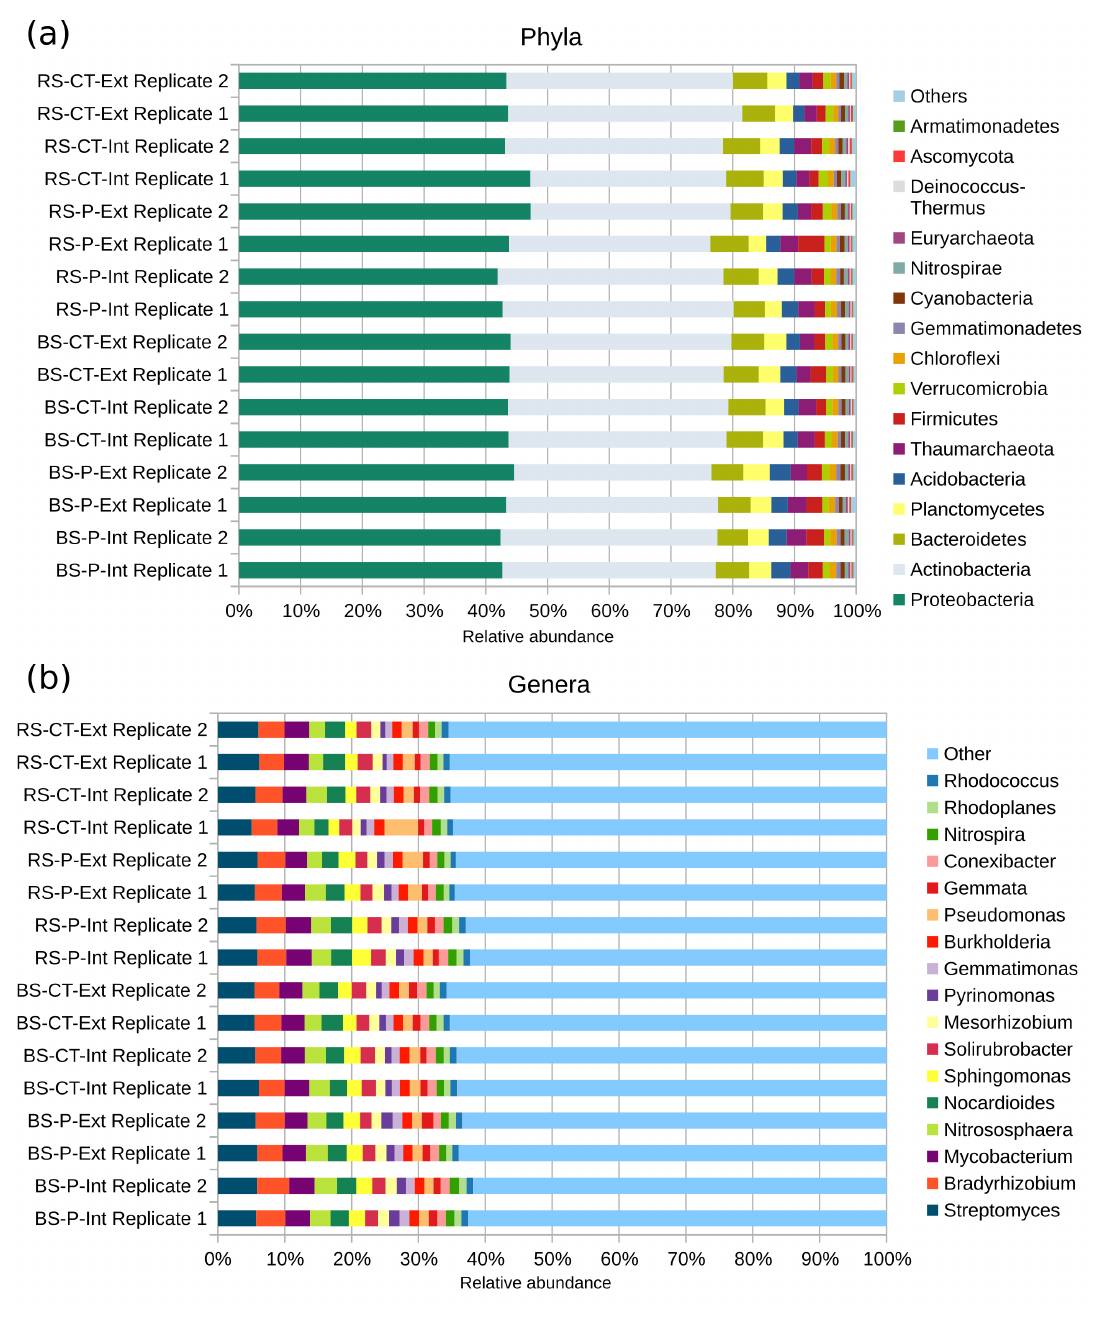
Figure 2. Taxonomic profiling of the soil microbial communities residing in the analyzed LTE-1 field plots on the rank of ( a ) phyla and ( b ) genera. Relative abundances of the most abundant phyla/genera are shown and were determined based on direct classification of reads normalized to the dataset sizes (fractions). In addition, 54 phyla and 3075 genera with relative abundances of less than one per mill or one percent, respectively are compiled as ‘Others’. The colors are ordered right-to-left according to the legend top–down. Abbreviations stand for bulk soil (BS) or root-affected soil (RS), tillage by mould-board plough (P) or cultivator (CT), and nitrogen fertilization intensive (Int) or extensive